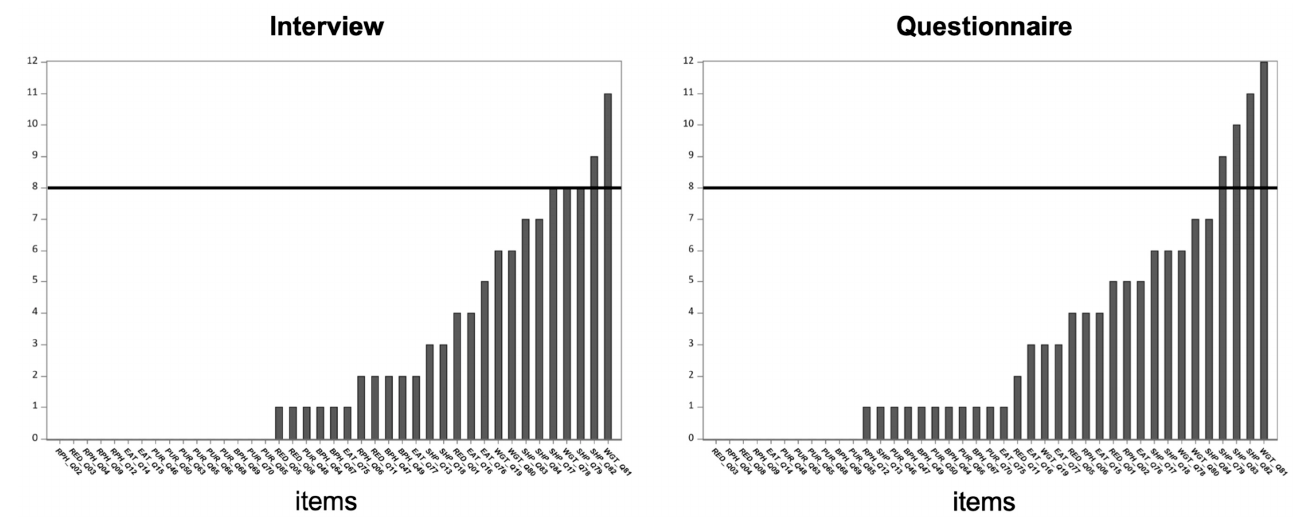
Figure 1. Graphical illustration of intermediate scores across items in the interview and questionnaire. Graph showing the number of participants (n = 30) intermediate scores (between 2 and 4) in the interview and questionnaire. The bold horizontal lines (at the 8 tick on the ordinate axis) are the cut offs between ordinal and not ordinal, with any items with bars breaching this line being considered ordinal. Items on the abscissa are in ascending order, for each format. The first three letters of each item correspond with a behavior/symptom category—RED, restraint for weight control; RPH, restraint to avoid physical discomfort; BPH, purging to avoid physical discomfort; PUR, purging for weight control; EAT, eating concern; WGT, weight concern; SHP, shape concern. See Appendix A for the full text of each item.